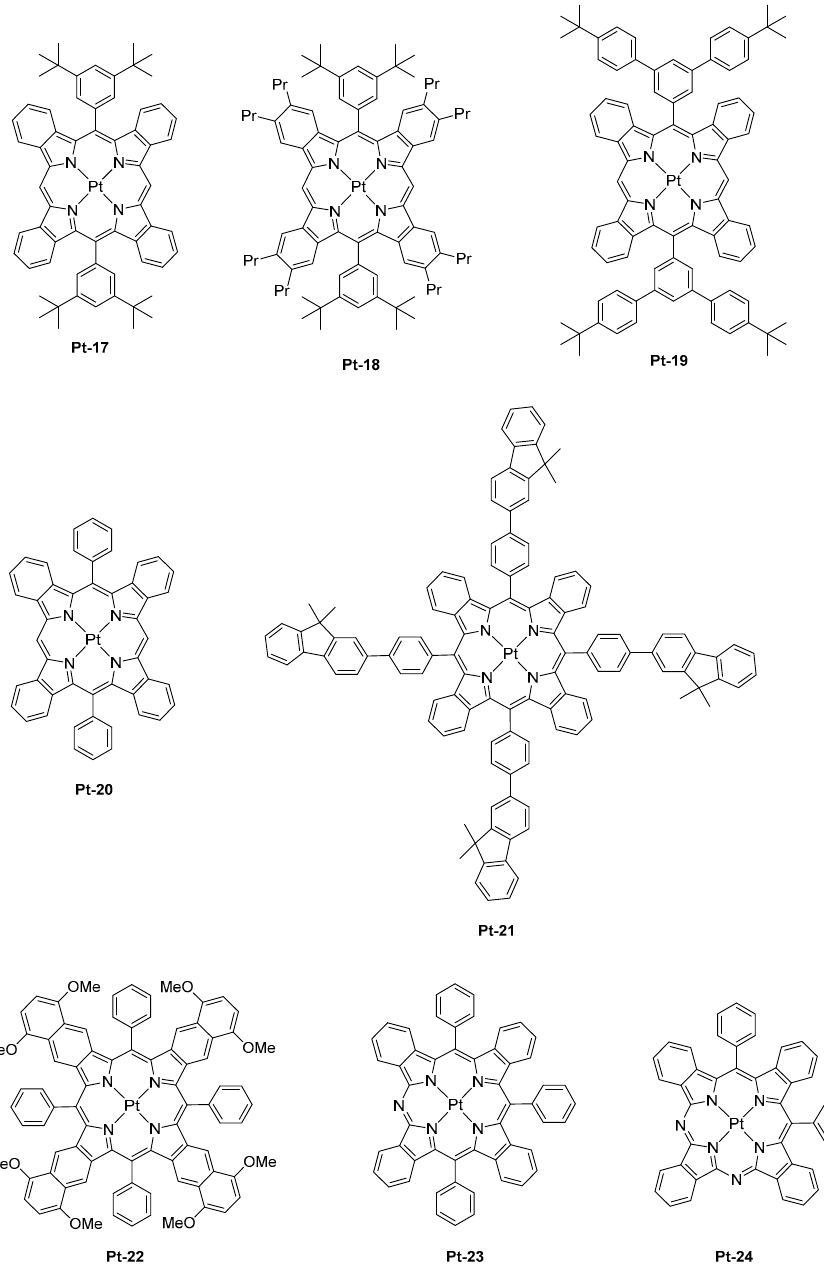
Figure 2. Pt-based near-infrared (NIR) emitters for light-emitting diodes.